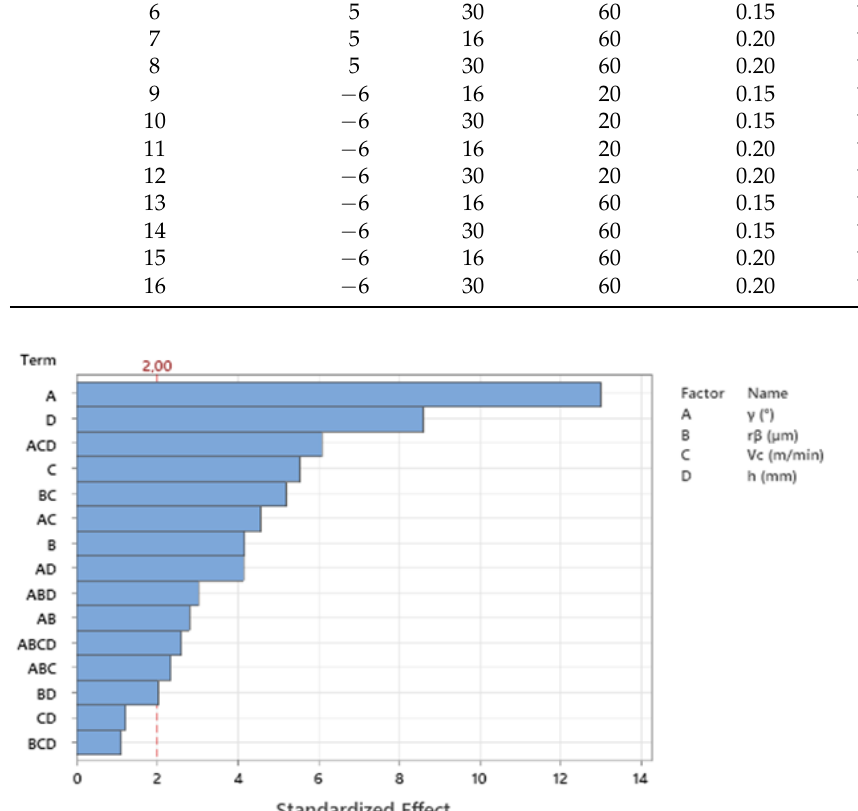
Figure 8. Pareto analysis of the factors affecting CCR based on all cutting conditions.